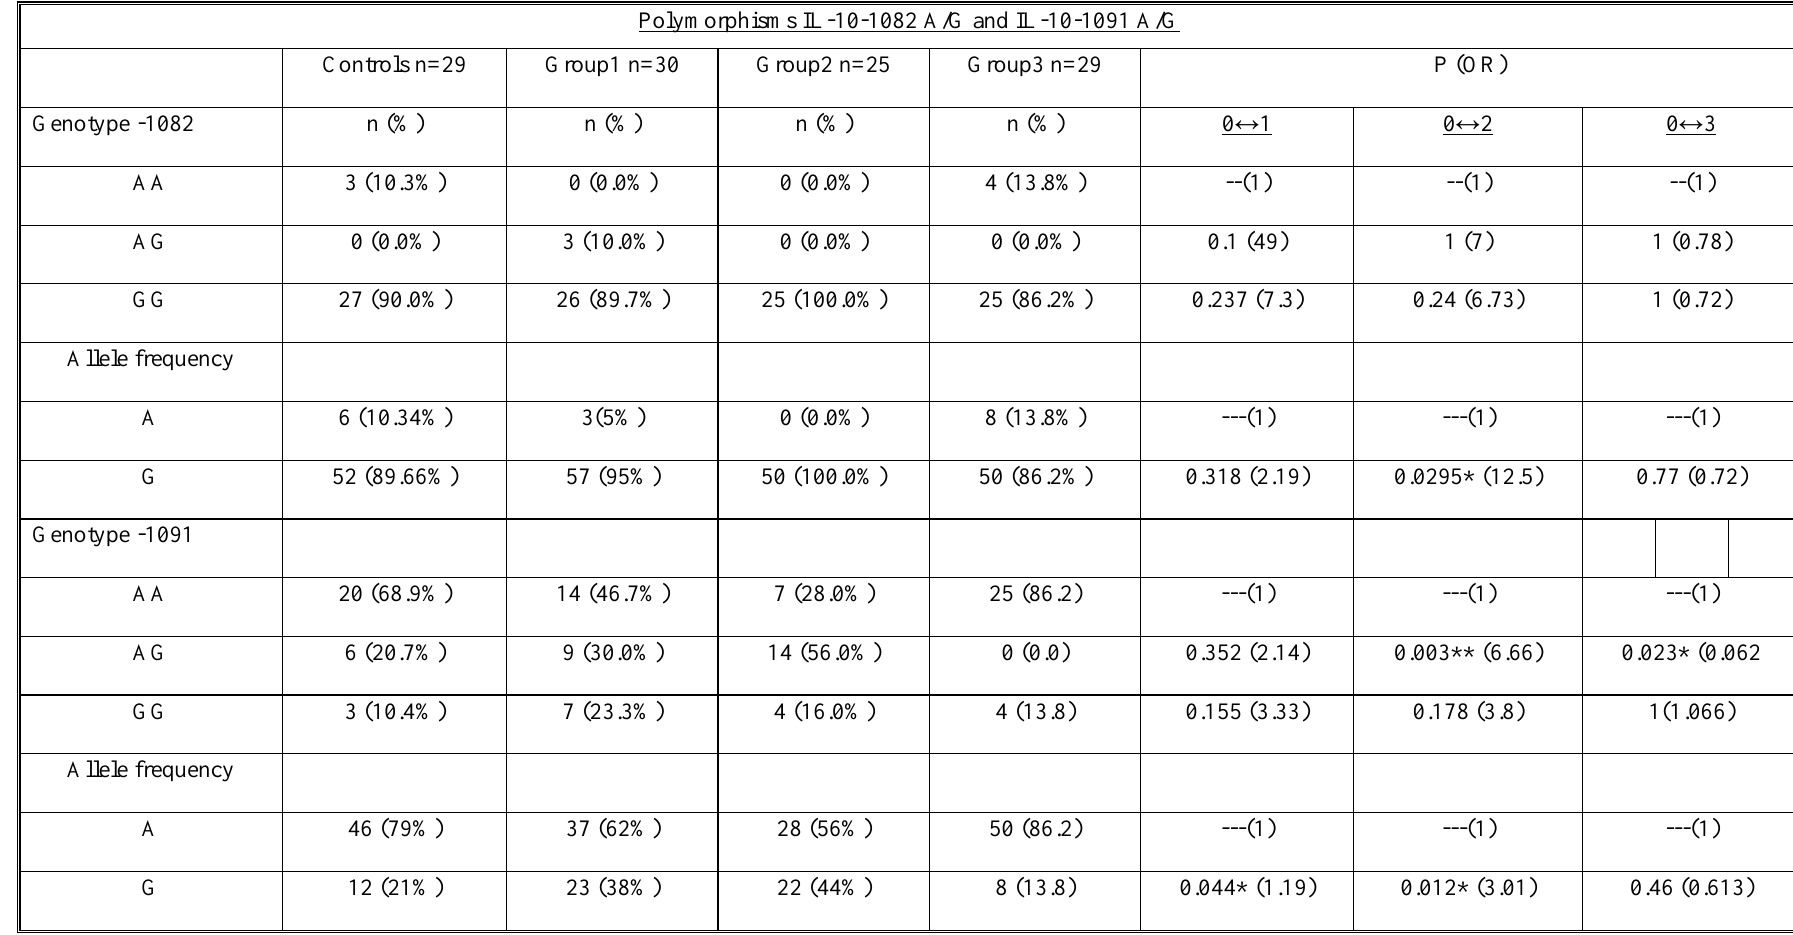
Table 1. Distribution of genotype frequencies of IL-10-1082 A/G and IL-10-1091 A/G